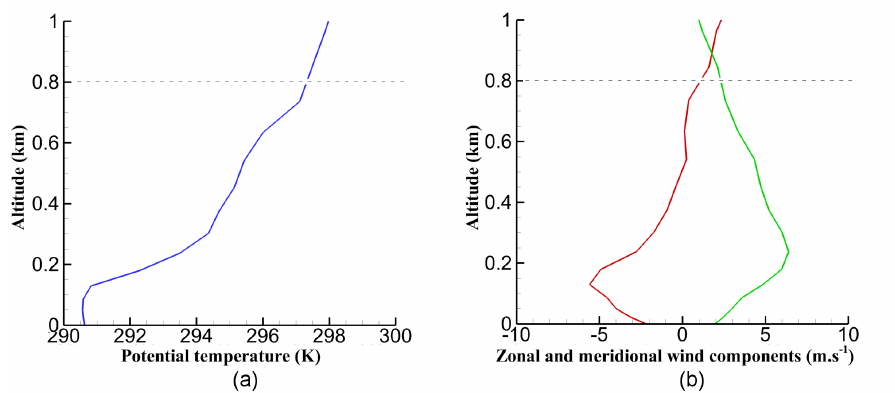
Figure 3. Large-scale vertical profiles at 0815 UTC at the Azote de France (AZF) fertilizer plant location: ( a ) Potential temperature; ( b ) zonal (in red line), and meridional (in green line) components of the mean wind. The dashed lines indicate the height of the large-eddy simulations (LES)